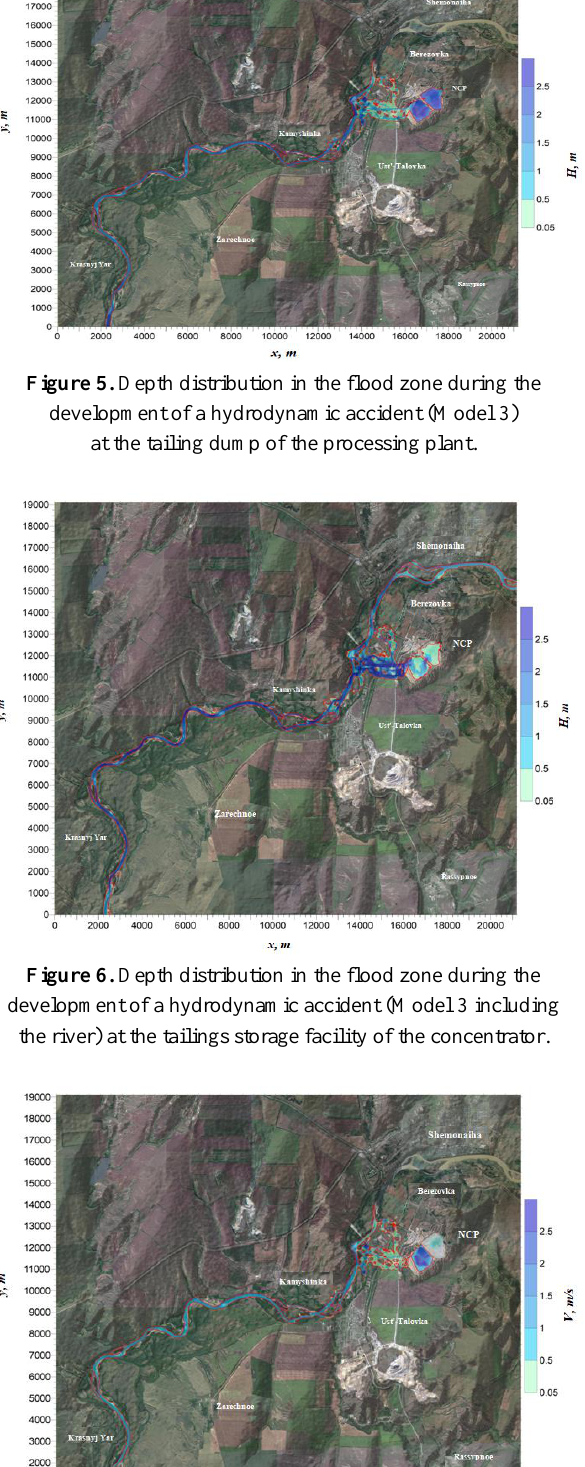
Figure 7. Distribution of the current velocity in the flooding zone during the development of a hydrodynamic accident (Model 3) at the tailing dump of the processing plant.